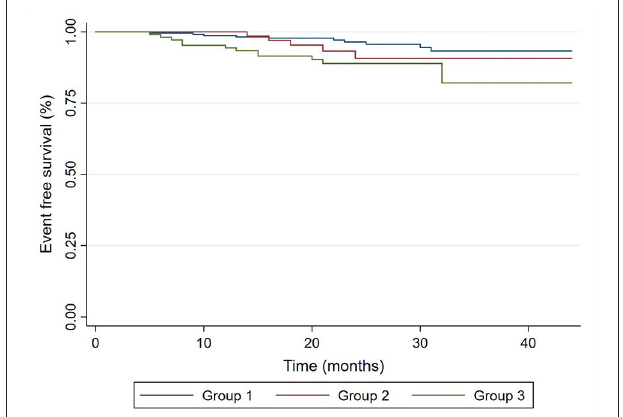
FIGURE 2 | Kaplan–Meier curves for freedom from HFE in CAD patients with normal ejection fraction. Group 1, normal PFR; Group 2, ischemia-related DD; Group 3, rest